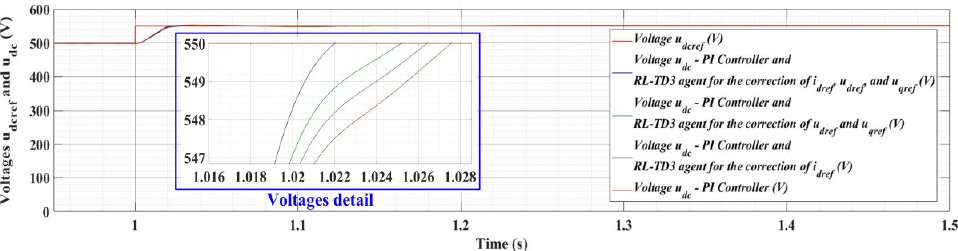
Figure 37. The comparison of voltage u dc for a step variation of the u dcref reference voltage from 500 V to 550 V using PI controllers and the RL-TD3 agent for the correction of the outer and inner loop commands (signal evolution of the type 1 PV array). Table 1. The performances of the GC-PV array control system based on PI-type controllers using the RL-TD3 agent.